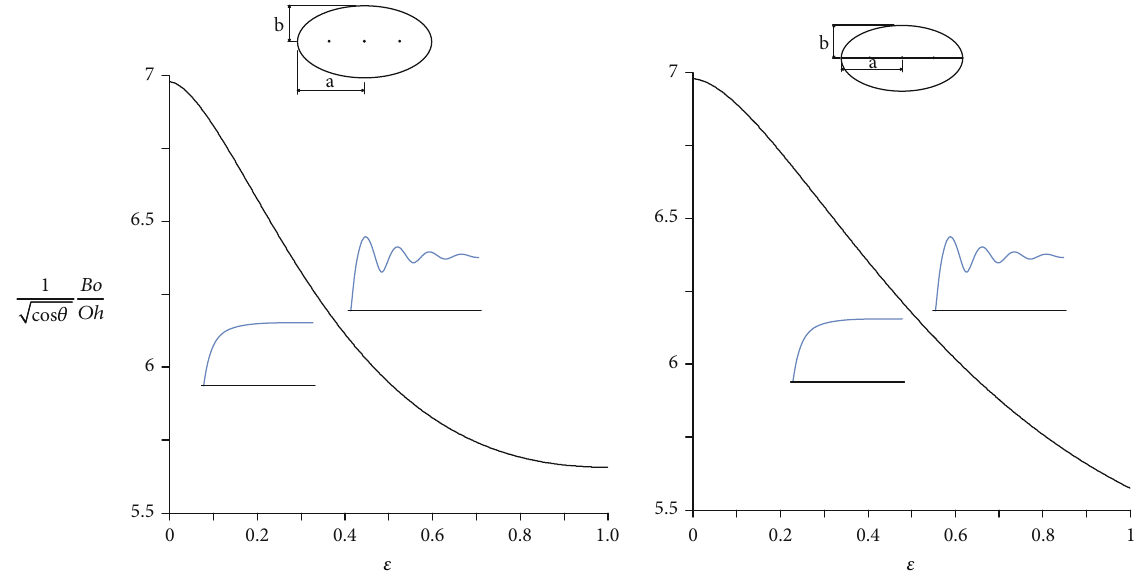
ffiffiffiffiffiffiffiffiffiffi p Þð Bo / Oh Þ for monotone cos θ